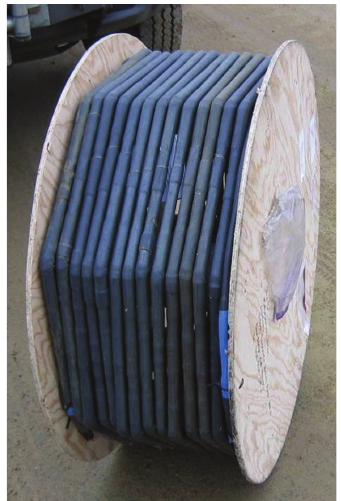
Figure 1: 32m (104ft) SAA on shipping